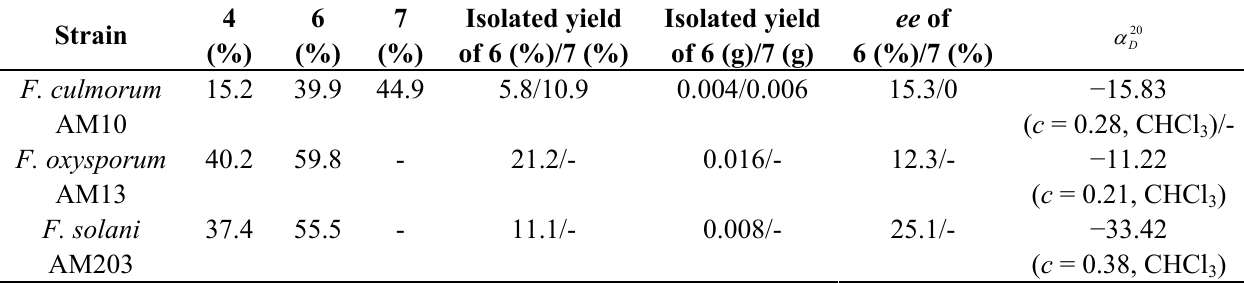
Table 4. Results of preparative biotransformations of lactone 5 after 14